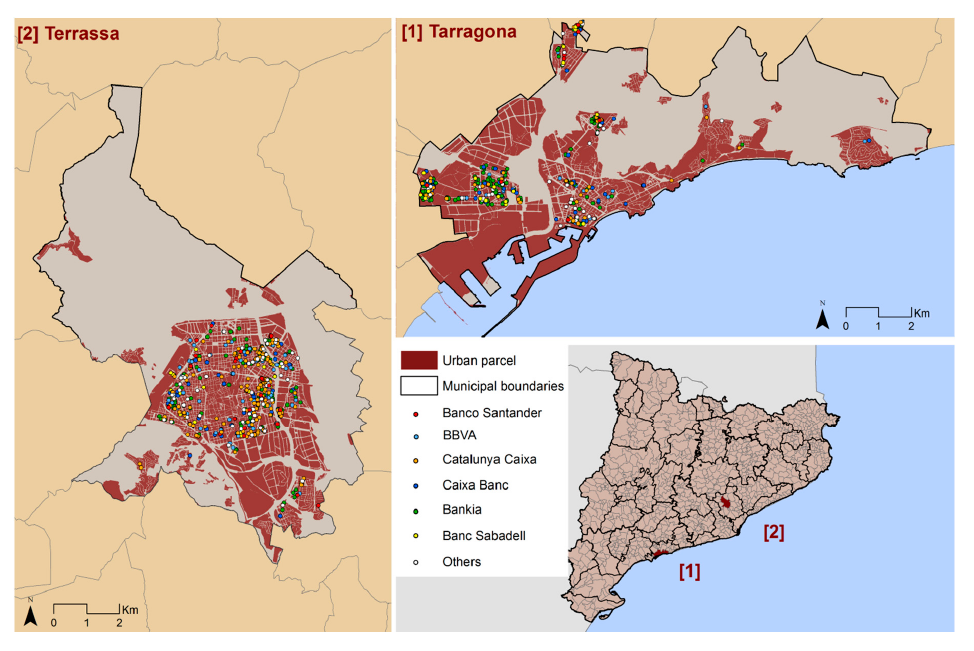
Figure 1. Study areas: HOBs (housing units owned by banks) in Tarragona and Terrassa. Source: own elaboration.